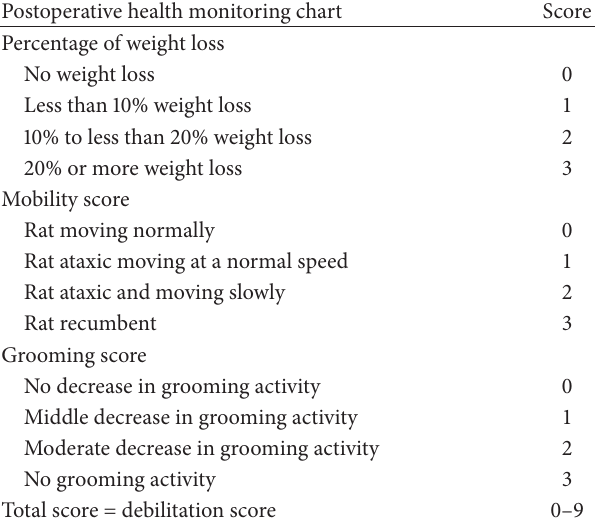
Table 1: Postoperative health monitoring chart. For a minimum of three days after surgery and until full recovery from the surgery, the rats were monitored for weight loss once a day and for mobility and grooming twice a day. For each day a debilitation score was calculated by cumulating the highest grooming and mobility scores with the weight loss score. A debilitation score of 0, 1 to 3, 4 to 6, and 7 to 9 meant that the rat health was not affected, middle affected, moderately affected, and severely affected by the surgery/polymer implantation,